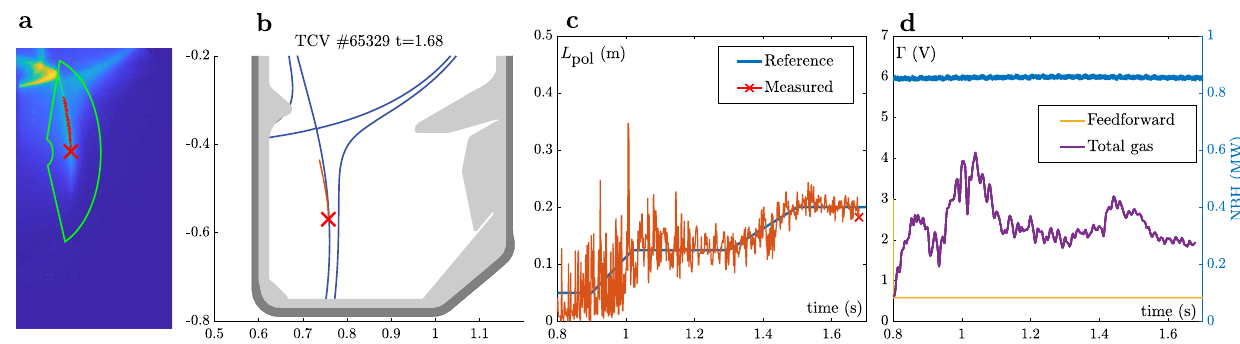
Fig. 7 H-mode feedback control results. Feedback control of the C-III emission front in H-mode con fi nement for a stair-case like reference trajectory. a Snapshot of a MANTIS image with region-of-interest, detected emission front, and divertor leg. b Mapping of the detected divertor leg and front to the poloidal cross section of TCV, together with the (of fl ine) LIUQE magnetic equilibrium reconstruction of the separatrix 46 . c Reference tracking with the requested L pol in blue, and real-time reconstruction in orange. The controller is active from t = 0.8 s onward. The ELM size and frequency change during the discharge due to the increase in core density, leading to a progressively smaller disturbance on the emission front measurement. d The gas valve feedfoward waveform in yellow, with superimposed feedback control signal in purple. The delivered NBH power is plotted in blue.